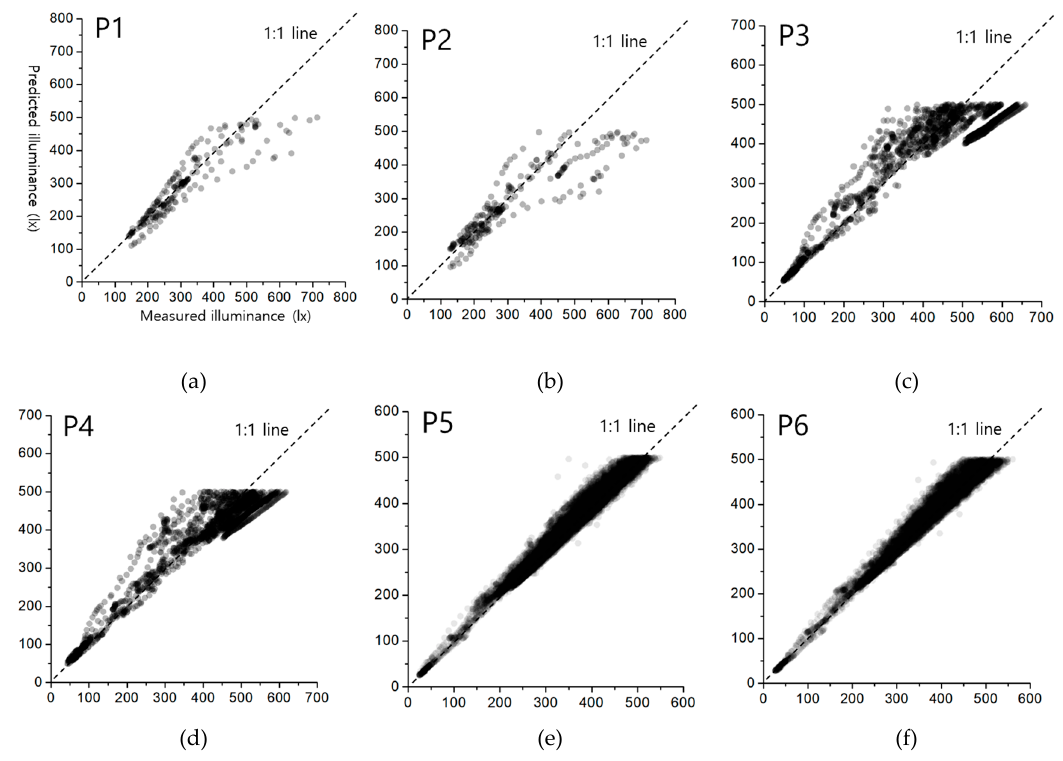
Table 2. As the variance of the scatter data of the daylight illuminance–photo sensor values increased, the prediction accuracy of the daylight illuminance decreased.